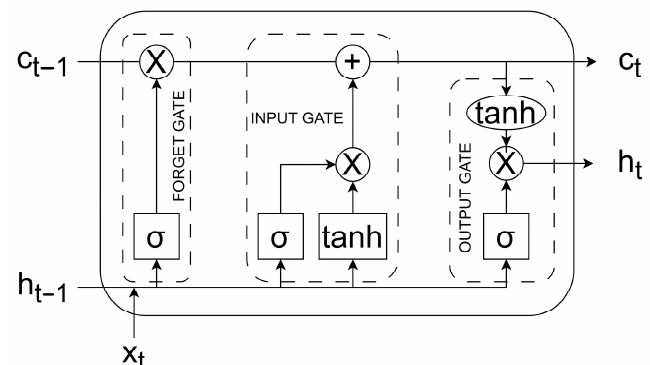
Figure 2. Internal structure of the LSTM cell.